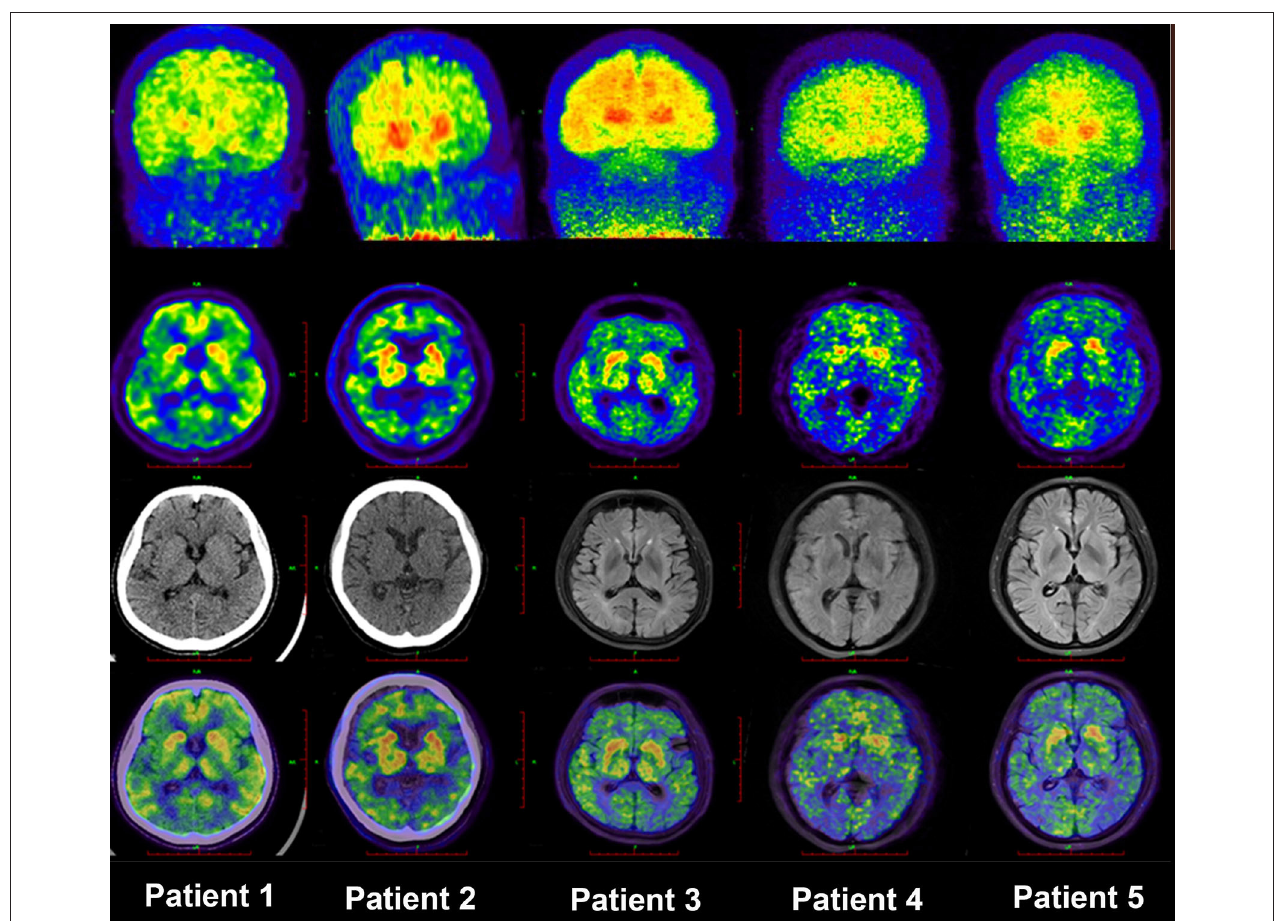
FIGURE 1 | MIP images of PIB-PET in five patients with EOFAD. The maximum intensity projection images of 11 C-PIB PET in five patients with EOFAD were shown, and increased PIB retention was detected in both the neocortex and striatum. 11 C-PiB, 11 C-labeled Pittsburgh compound-B; EOFAD, early-onset familial Alzheimer’s